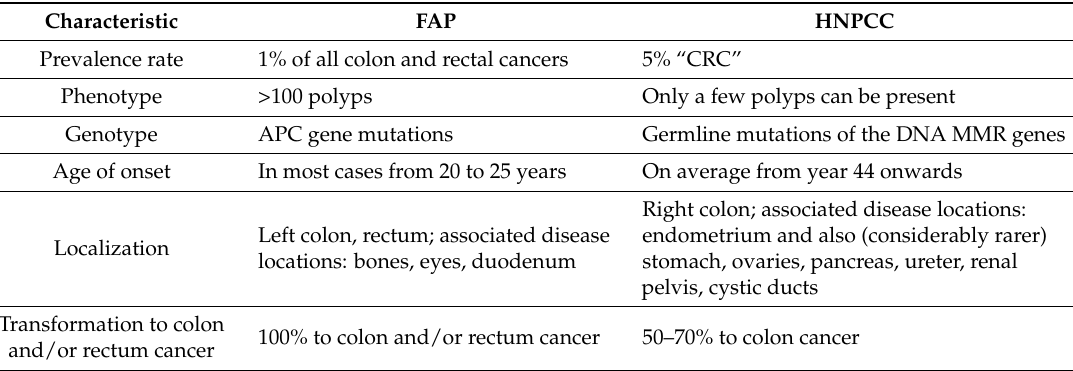
Table 1. Differences between familial adenomatous polyposis coli (FAP) and hereditary non-polyposis colorectal cancer